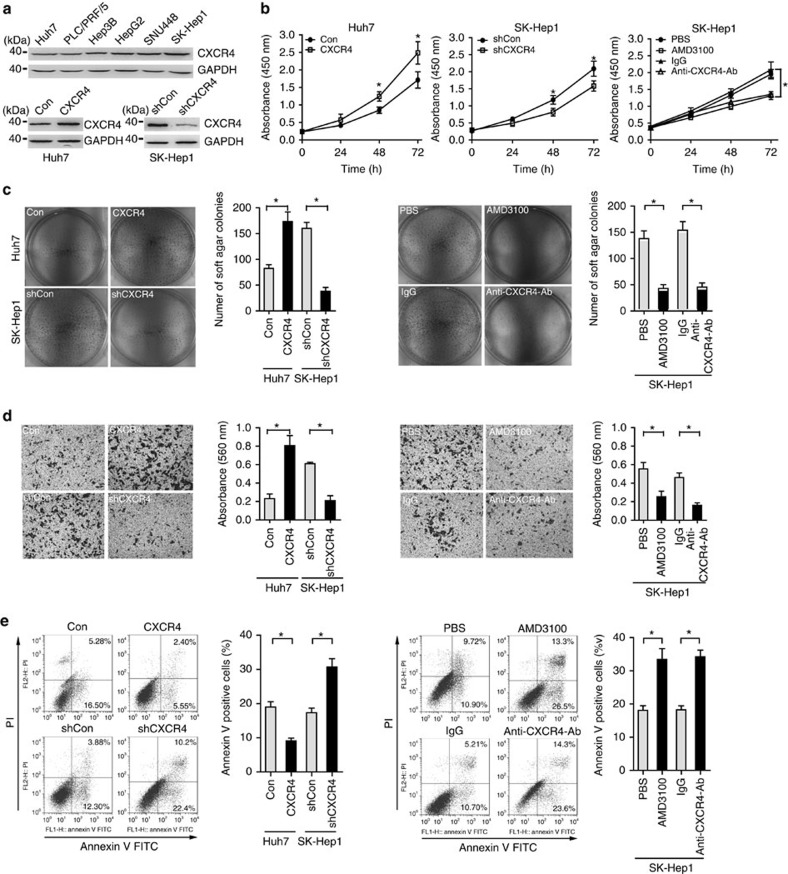
CXCR4 promotes hepatoma cell proliferation and survival in vitro.(a) Western blot analysis of CXCR4 and GAPDH for Huh7, PLC/PRF/5, Hep3B, HepG2, SNU448 and SK-Hep1 cells (upper panel), for Huh7 cells stably transfected with empty vector or CXCR4 (lower left panel) and for SK-Hep1 cells stably transfected with nonspecific shRNA (shCon) or CXCR4-specific shRNA (shCXCR4) (lower right panel). Data are representative immunoblots of three independent assays. (b) Cell proliferation analysis for Huh7 cells without or with stably CXCR4 overexpression, SK-Hep1 cells without or with stably CXCR4 knockdown, SK-Hep1 cells without or with AMD3100 (100 nM) or CXCR4-neutralization antibody (100 μg ml−1) treatment (n=3). Student's t-test, *P<0.05. Error bars in panels are defined as s.d. (c) Representative micrographs and quantification of soft agar colonies for above-mentioned hepatoma cells (n=3). Student's t-test, *P<0.05. Error bars in panels are defined as s.d. (d) Representative micrographs and quantification of the above-mentioned hepatoma cells in the Transwell migration assay (n=3). Student's t-test, *P<0.05. Error bars in panels are defined as s.d. (e) Representative dot plots of flow cytometric analysis of above-mentioned hepatoma cells cultured in serum-deprivation medium for 48 h. Cells were subjected to annexin-V and Propidium lodide (PI) staining, and the percentage of cells displaying annexin-V single positive and annexin-V, PI double positive are denoted (n=3). Student's t-test, *P<0.05. Error bars in panels are defined as s.d.